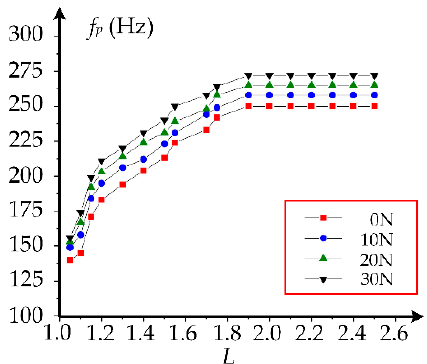
Figure 17. Peak vibration frequency with different axial loads.